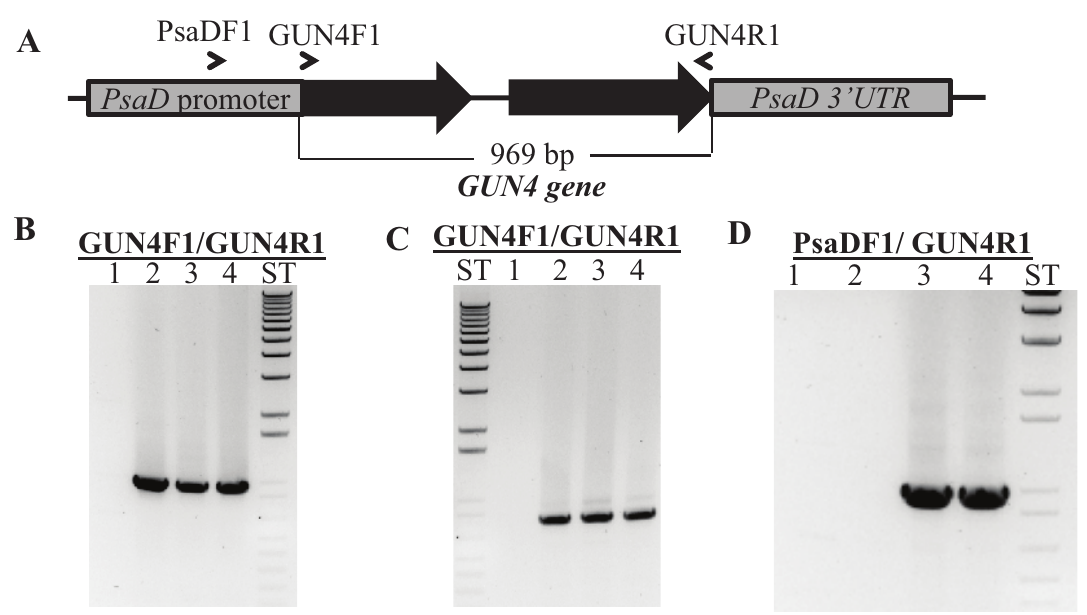
Figure 11. Molecular analyses of gun4-II complements. ( A ) A schematic diagram of the GUN4 -pDBle construct. Primers used for PCR are shown on the map. ( B ) Genomic DNA PCR analyses with GUN4 cloning primers (product size: 969 bp). Lane 1: gun4-II ; Lane 2: 4A+; Lane 3: gun4-19 ; Lane 4: gun4-27 . ( C ) RT-PCR analyses with GUN4 cloning primers (product size: 802 bp). Lane 1: gun4 ; Lane 2: 4A+; Lane 3: gun4-19 ; Lane 4: gun4-27 . ( D ) Genomic PCR analyses using a PsaD 5 ′ UTR specific forward primer with a GUN4 cloning reverse primer (product size: